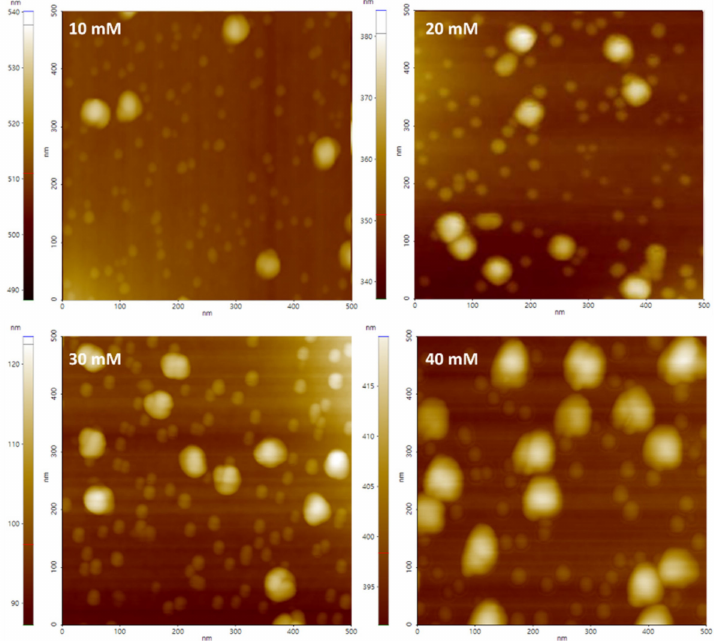
Figure A3. Two-dimensional tapping mode AFM images (500 × 500 nm) for Ag samples prepared at different